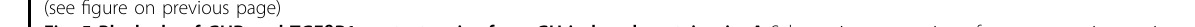
Fig. 5 Blockade of GHR and TGF β R1 protects mice from GH-induced proteinuria. A Schematic presentation of mouse experimentation. B Urinary albumin creatinine ratio (UACR) and C glomerular fi ltration rate (GFR) was estimated in the experimental mice. Mean ± SD. **** p < 0.0001 by one-way ANOVA post hoc Dunnett test. Each dot represents the average value of three independent experiments from a single mouse. D Silver staining was performed to the urine samples from the mice. n = 3. BSA bovine serum albumin, M protein standard marker. E qRT-PCR analysis in mouse podocytes from control and treatment groups. Mean ± SD. **** p < 0.0001 by one-way ANOVA post hoc Dunnett test. Each data point represents the average value of three independent analysis from each mouse ( n = 6). F Immunoblotting analysis in mouse podocytes from control and treatment groups. ( n = 3). G Representative images of immunohistochemical staining for anti-WT1 (podocytes) by DAB in the glomerulus sections from control and treatment groups. Magni fi cation ×630, Scale bar = 20 μ m. ( n = 3). The average number of WT1 + cells (right panel) in the mice glomerulus was quanti fi ed using ImageJ (NIH). Mean ± SD. **** p < 0.0001 by one-way ANOVA post hoc Dunnett test. Each data point represents the average value of three independent experiments from each mouse ( n = 6). H Representative image of PAS (periodic acid – Schiff), MT (Masson ’ s trichrome), and H&E (hematoxylin and eosin) staining of glomeruli, and TEM (transmission electron microscopy) imaging of podocytes. Magni fi cation prepesnted as a dot plot, where each dot represents the average value of ten glomeruli from each mouse ( n = 6). Mean ± SD. **** p < 0.0001 by one- way ANOVA post hoc Dunnett